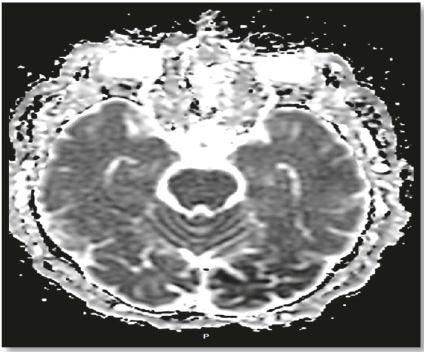
Figure 3: Periictal brain MRI ADC mapping showing bilateral occipital hypointense signal alteration (left > right). Abbreviations: ADC, apparent diffusion coefficient; MRI, magnetic resonance